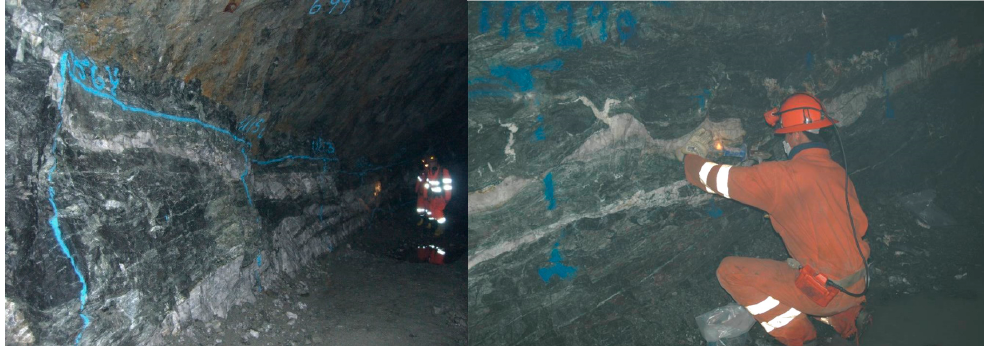
Figure 9. Chip sampling at Nalunaq mine. Each sample comprises three cuts, with a central cut (see blue lines on both pictures) and a separate cut 1 m either side of the centre cut.